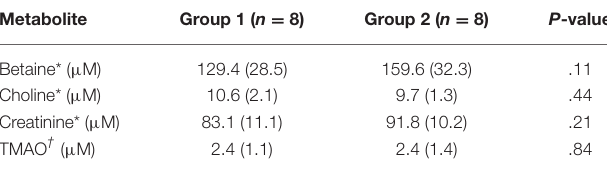
TABLE 3 | Plasma levels of betaine, choline, creatinine, and trimethylamine- N -oxide (TMAO) in 16 dogs at baseline.